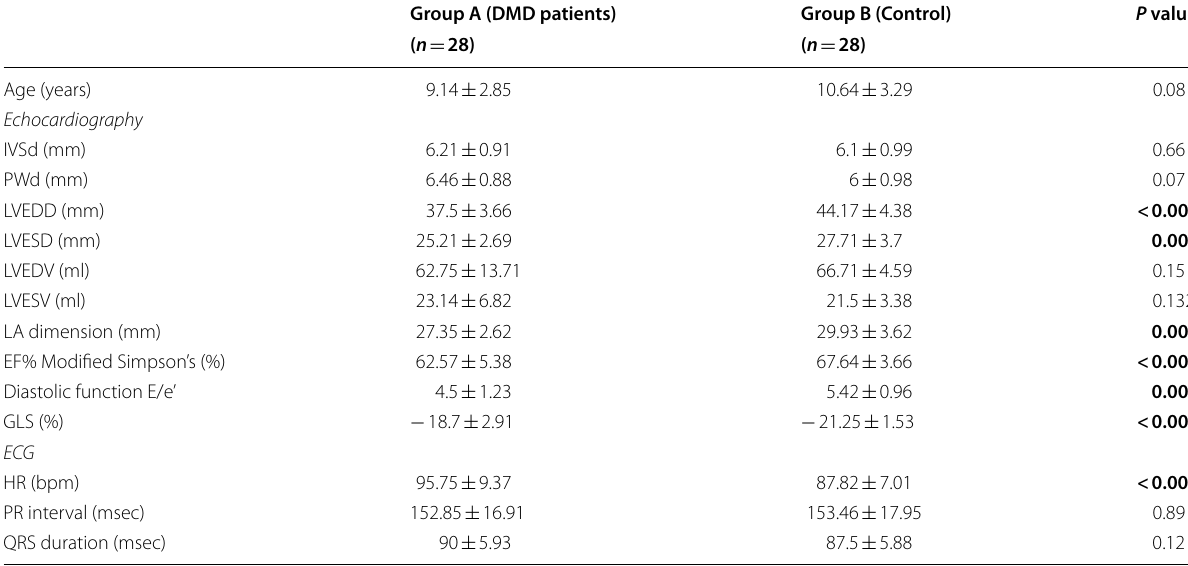
Table 1 Comparing ECG and echocardiographic findings between group A and group B